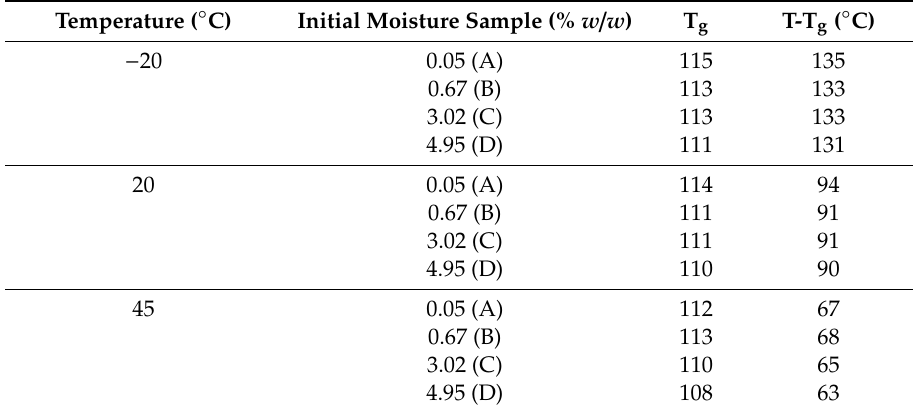
Figure 7. ELISA Diphtheria binding activity (IU/mL) after 6 months of storage for different initial moisture samples of FD IgG 50 mg/mL (A = 0.05% ± 0.01% w/w, B = 0.67% ± 0.14% w/w, C = 3.02% ± 0.06% w/w and D = 4.95% ± 0.40% w/w) at − 20 °C, 20 °C and 45 °C. Error bars represent 95% confidence intervals. Table 3. Comparison of difference in storage temperatures and glass transition temperatures after 6 months of storage.